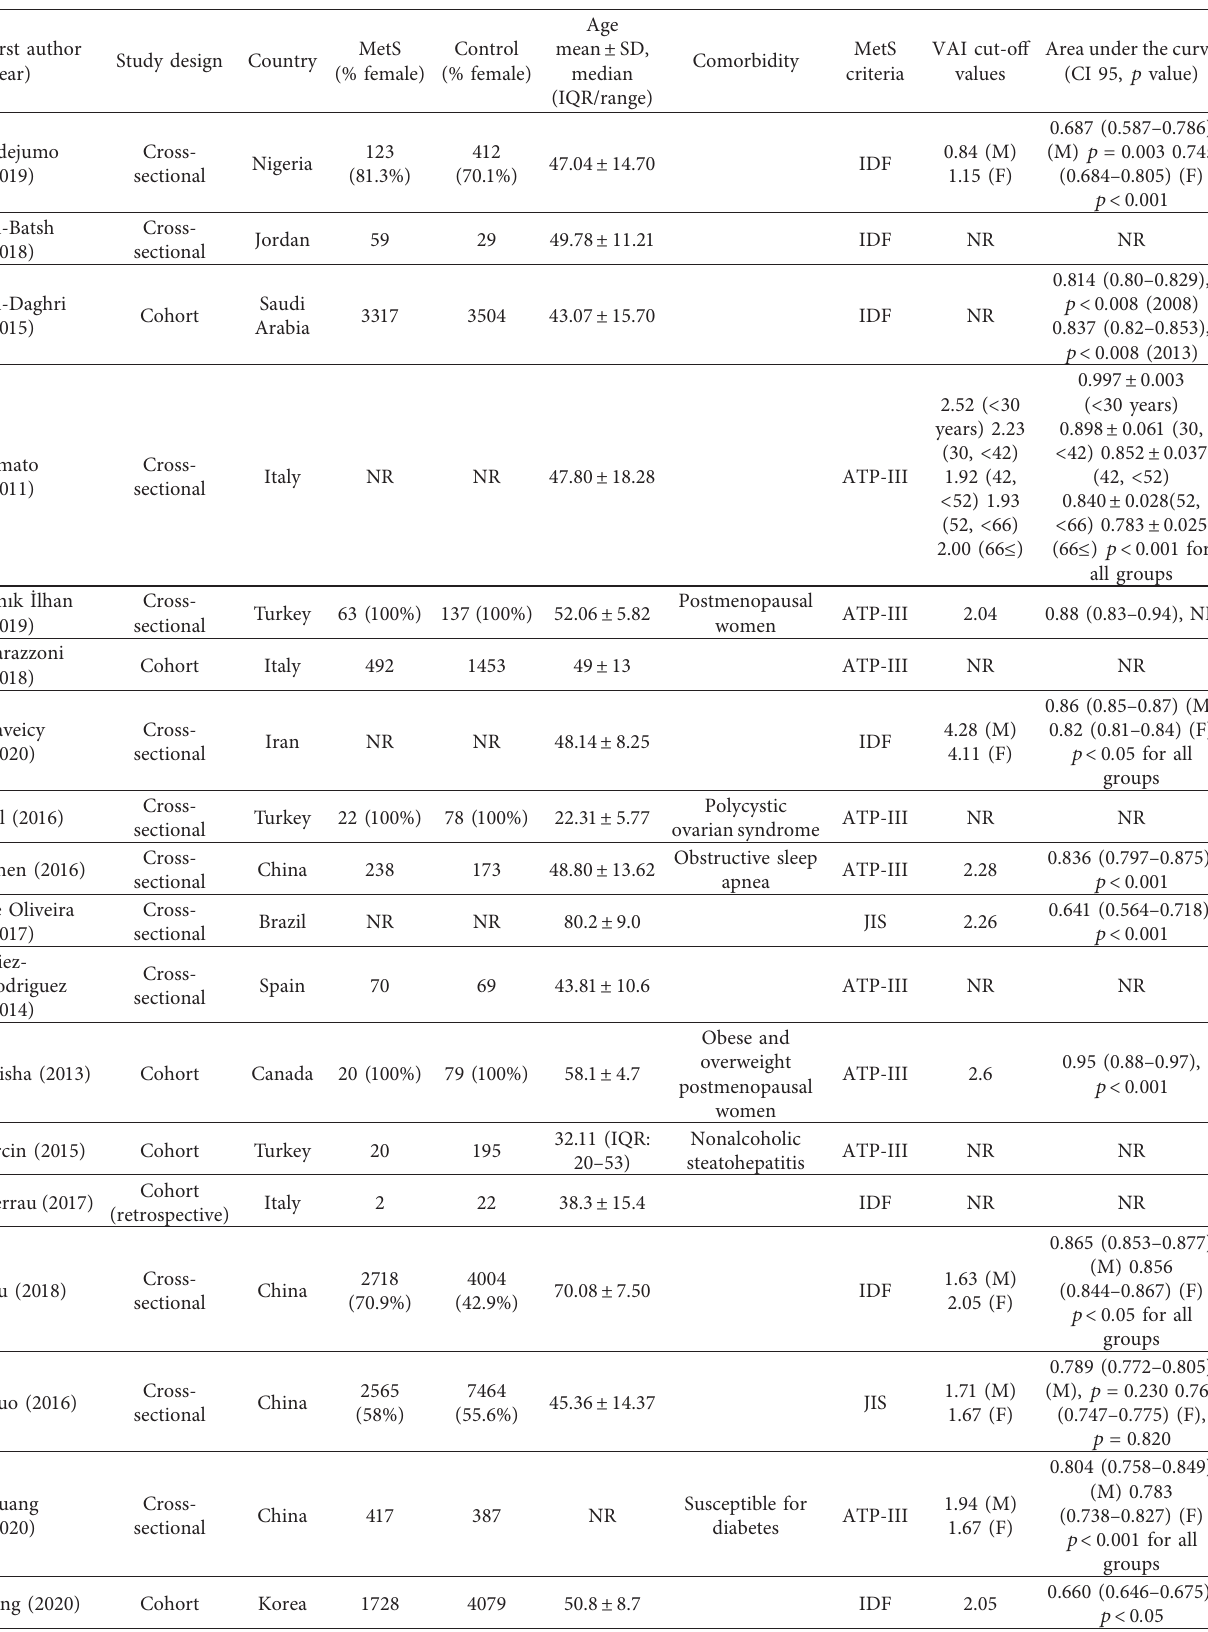
Table 1: Characteristics of the included